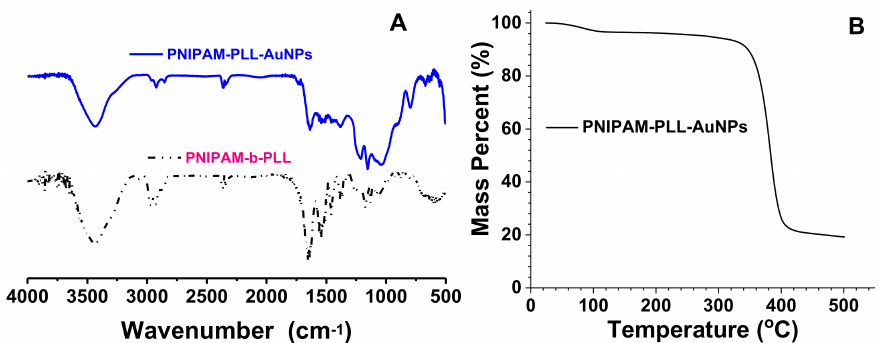
Figure 2. FT-IR spectra of PNIPAM- b -PLL and PNIPAM-PLL-AuNPs ( A ); TGA spectrum of PNIPAM-PLL-AuNPs ( B ).